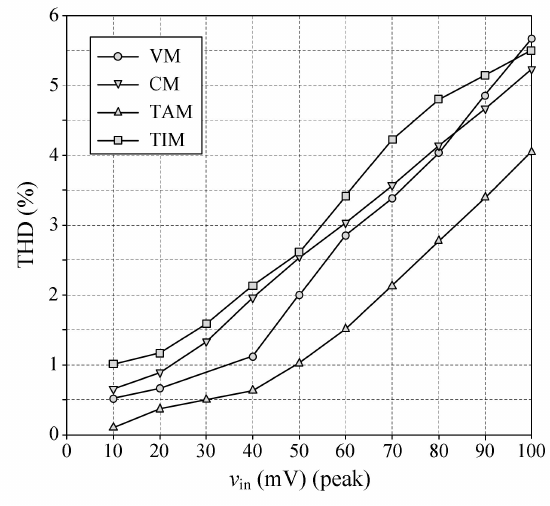
Figure 24. Measured THD values of the BP outputs for various sinusoidal input signals at a frequency of 1.59